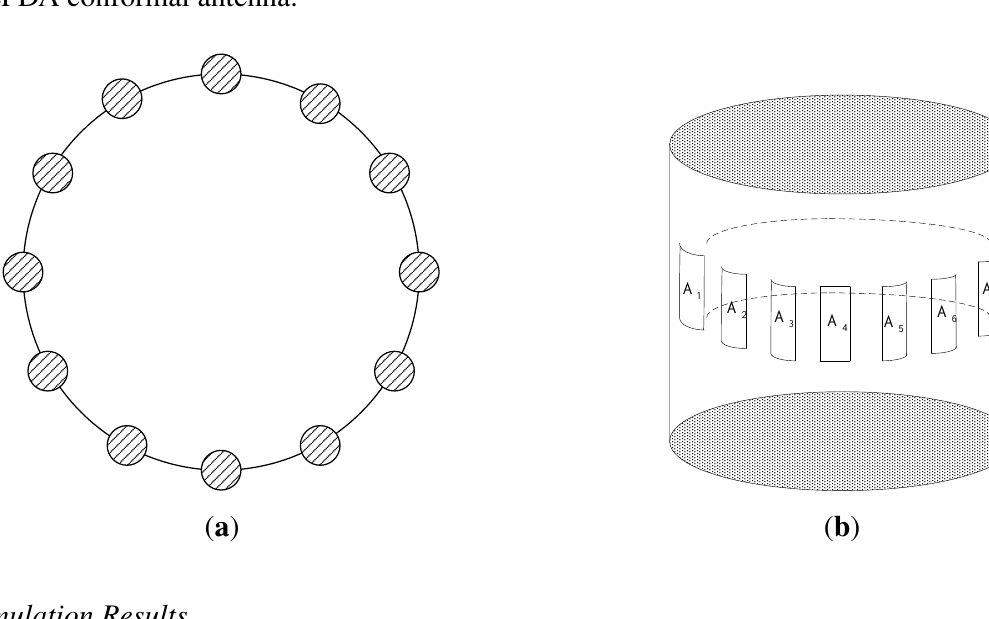
Figure 10. Antenna placement. ( a ) 2D array of the planar spiral antenna; ( b ) 3D array of LPDA conformal